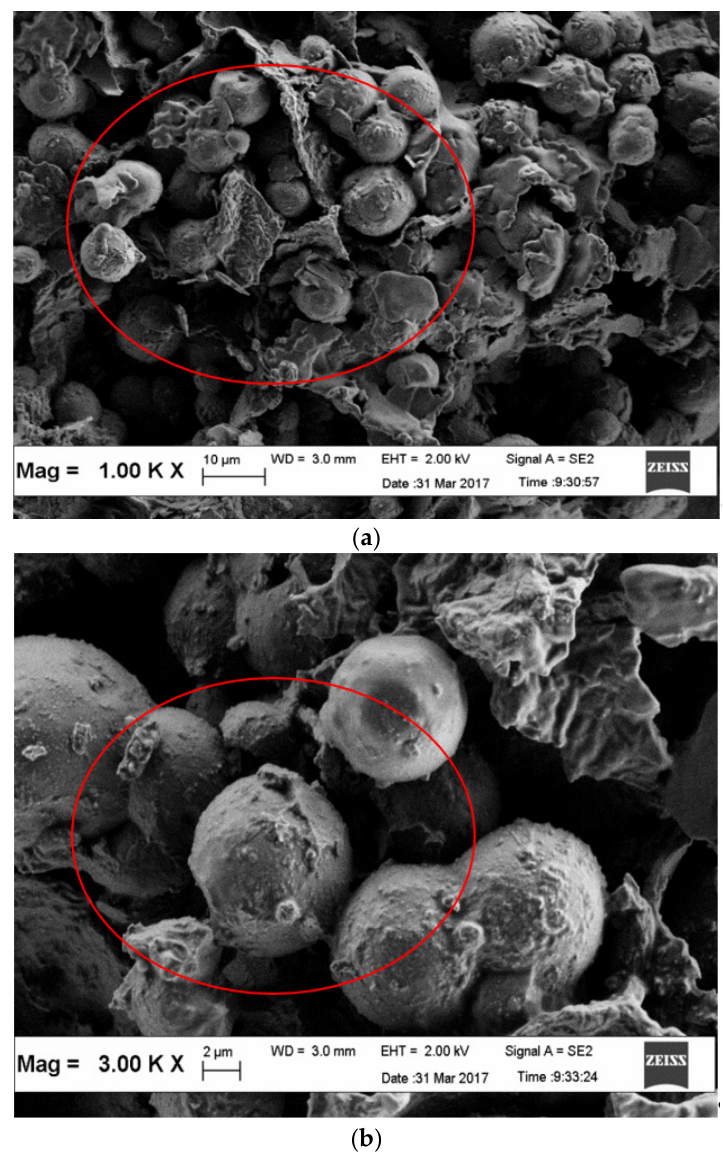
Figure 4. FESEM of Nephelium lappaceum seed. ( a ) 1000× magnification; ( b ) 3000× magnification.